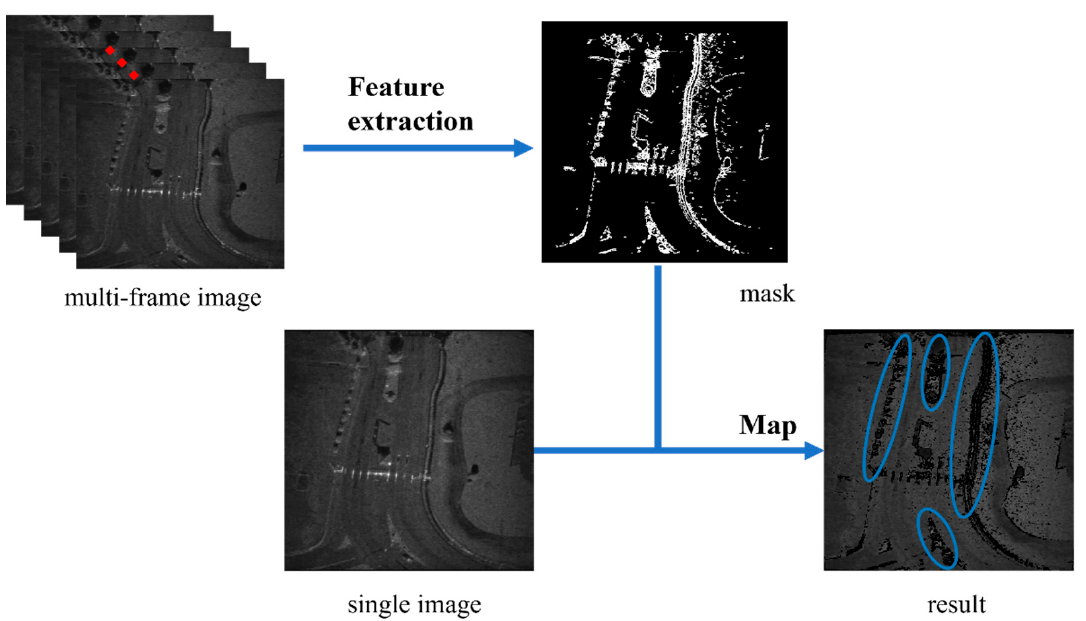
Figure 3. The process of building a mapping function.